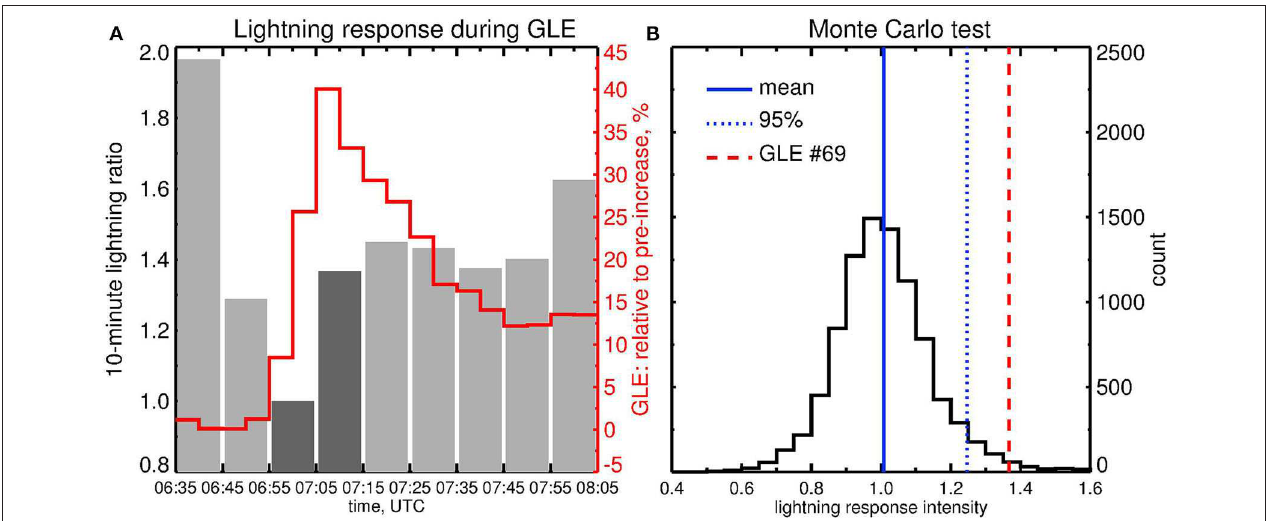
Frontiers in Physics |